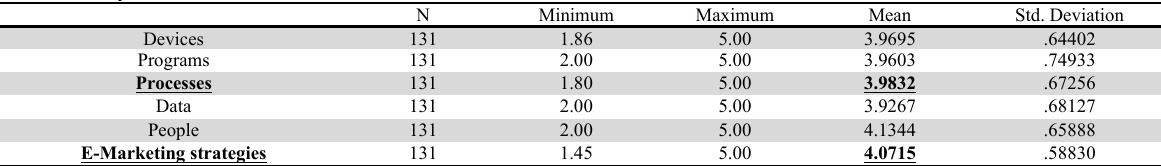
The summary of some basic statistics